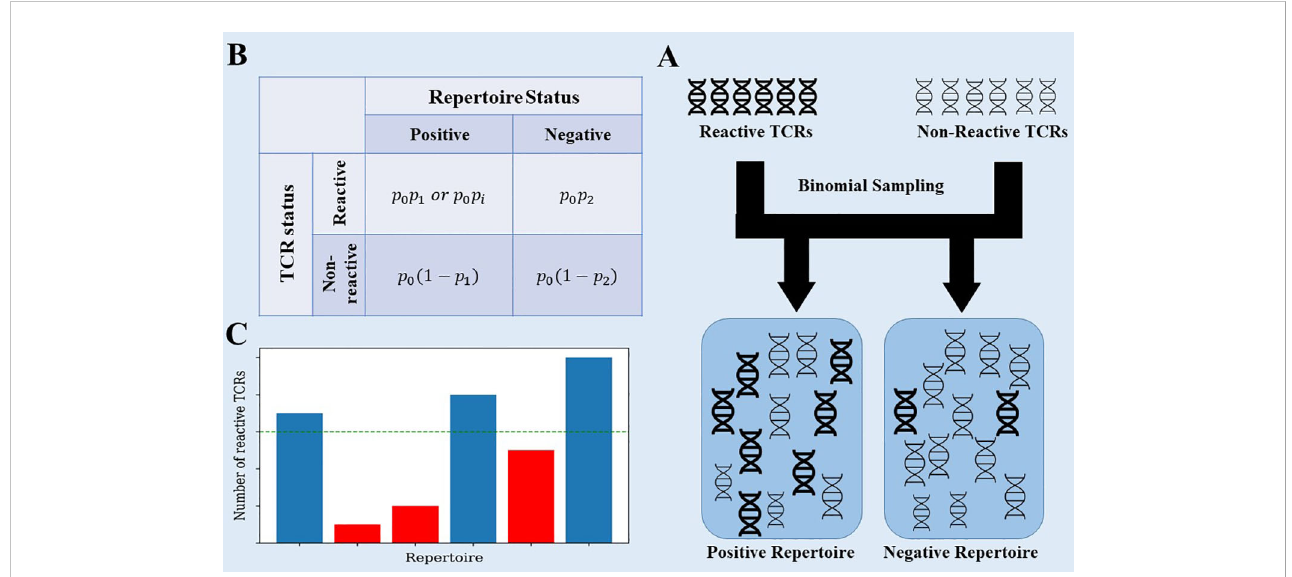
FIGURE 2 (A) The data generation process of the toy model. Each generated repertoire is created using binomial sampling from a collection of positive and negative TCRs. (B) The data generation process uses 3 probabilities: p 0 - the probability that a TCR would be selected in any patient, p 1 , p 2 - the same for TCRs associated with CMV in CMV+ and CMV- samples. We also tested a model where we replaced p 1 with p i ~N( p 1 , s 2 ) for each positive TCR t i . (C) When classifying the generated repertoires, the reactive TCRs are extracted from each repertoire using the c 2 score on the training set, and then counted in the test set. Repertoires with a large enough number of reactive TCRs are classi fi ed as